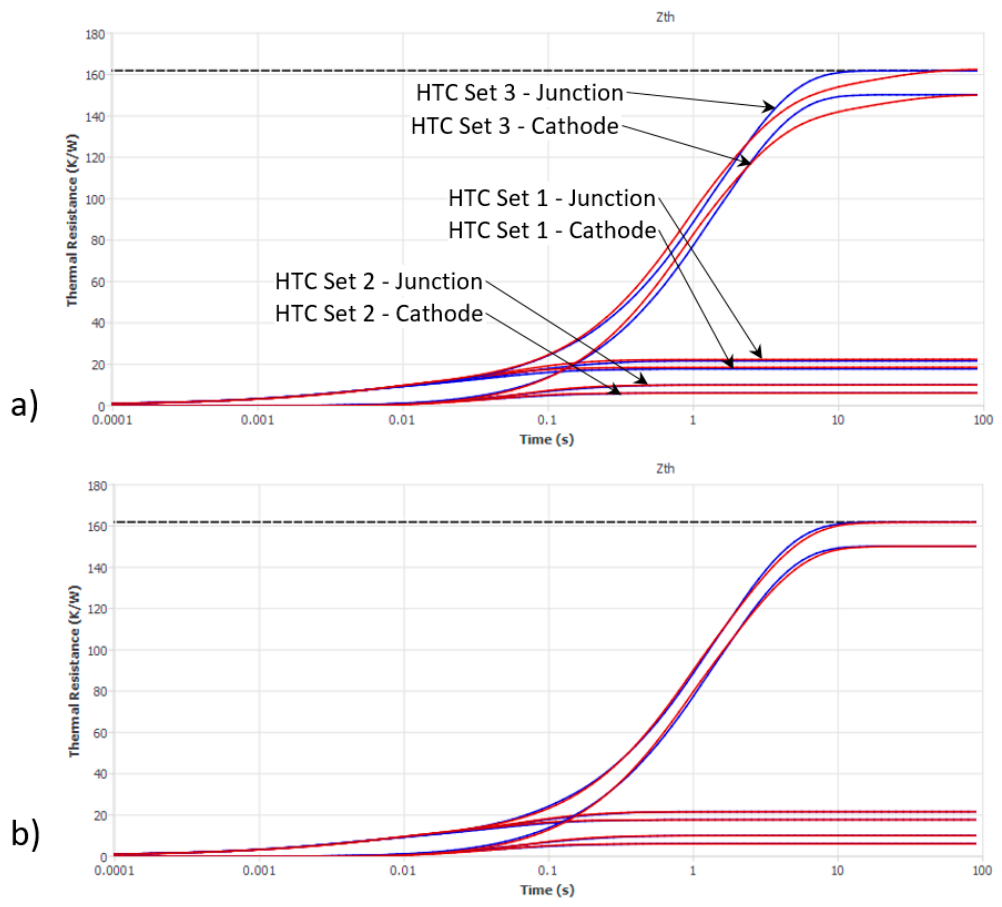
Figure 4. CTM (red curves) and detailed model (blue curves) Junction and Cathode thermal response comparisons for the three HTC sets: ( a ) for the initial assumed CTM resistance and capacitance values; ( b ) for the final calibrated CTM.